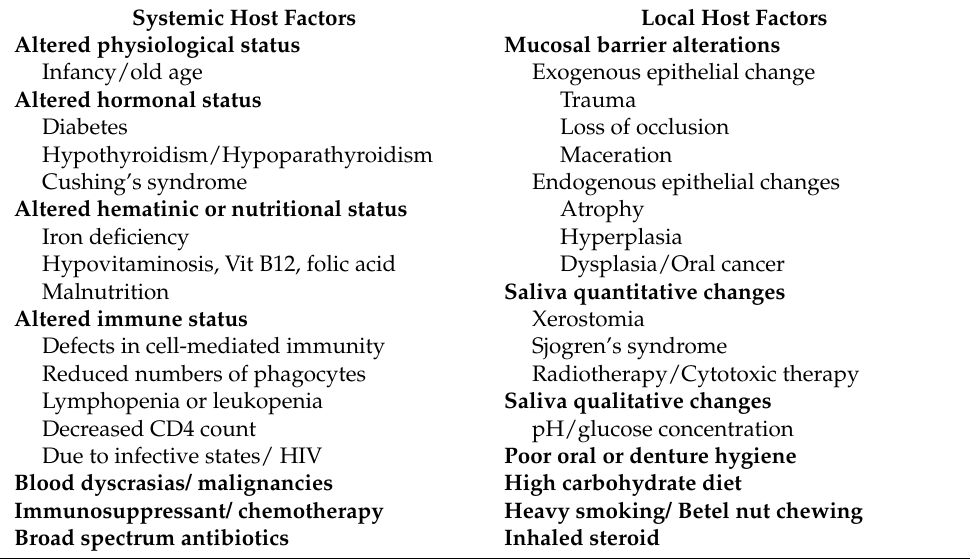
Table 1. Systemic or local host factors predisposing to oral